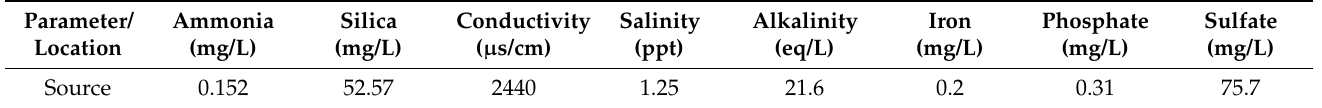
Table 3. Average concentrations of the chemicals at the source of the hot